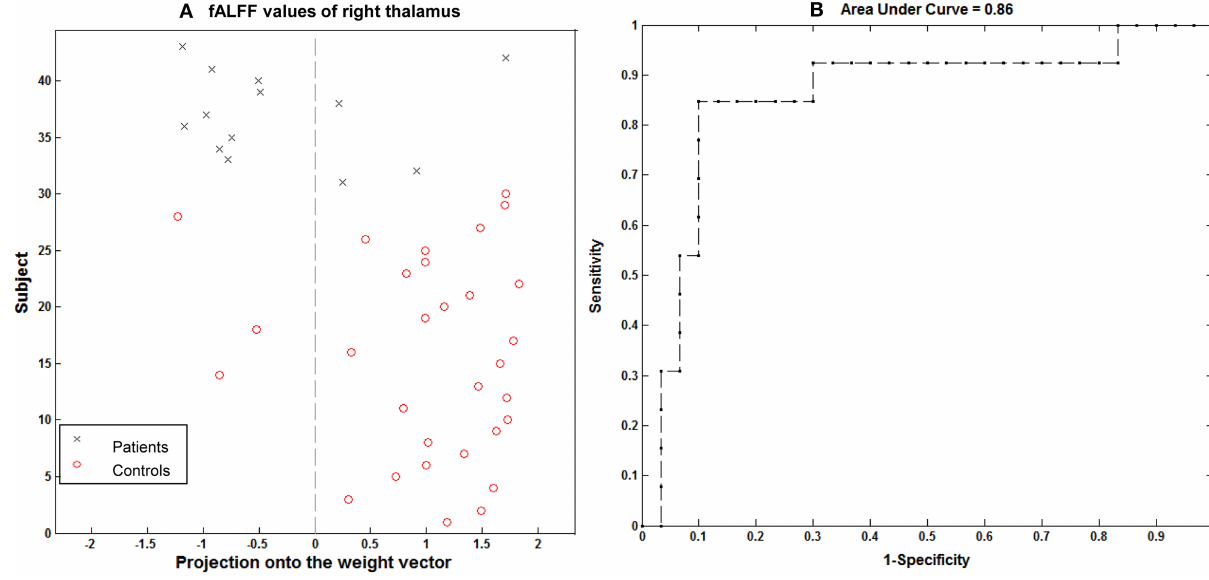
FIGURE 7 | Classification plot (A) and receiver operating characteristic curve (B) for the comparison between 13 children with GTCS and 30 healthy controls using fALFF from right thalamus of resting-state fMRI. This yielded a total accuracy of 83.72% (90% sensitivity, 69.23% specificity), statistically significant at P <